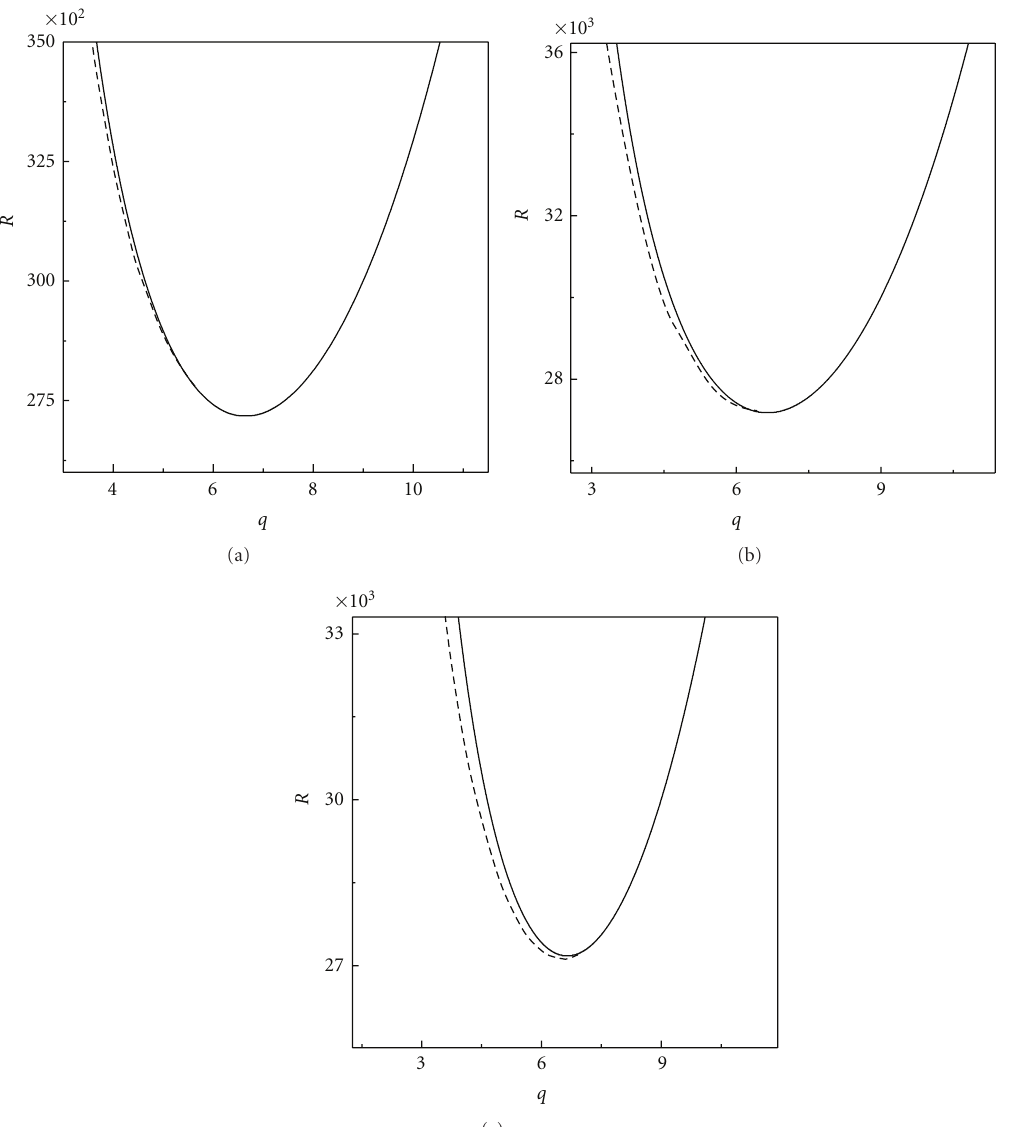
Figure 2: Neutral curves for the stationary bifurcation (solid lines) and for the Hopf bifurcation (dashed lines) near the codimension two point for Q = 2000, D a = 1500, Λ = 0 . 85, φ = 0 . 9, Pr 1 = 1, and M = 0 . 9, (a) Pr 2 = 1 . 27, (b) Pr 2 = 1 . 3, (c) Pr 2 = 1 . 35 x -axis wave number, y -Rayleigh numbers R s , R o